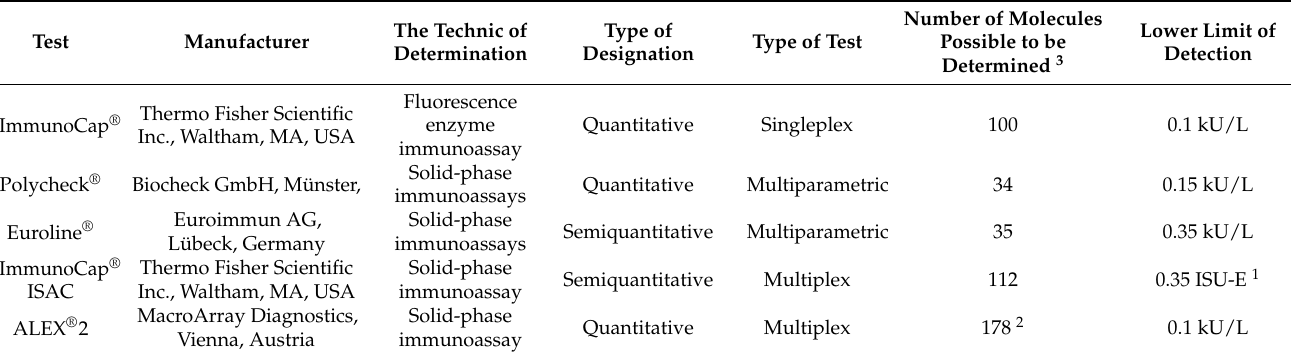
Table 2. Characteristics of selected tests used for